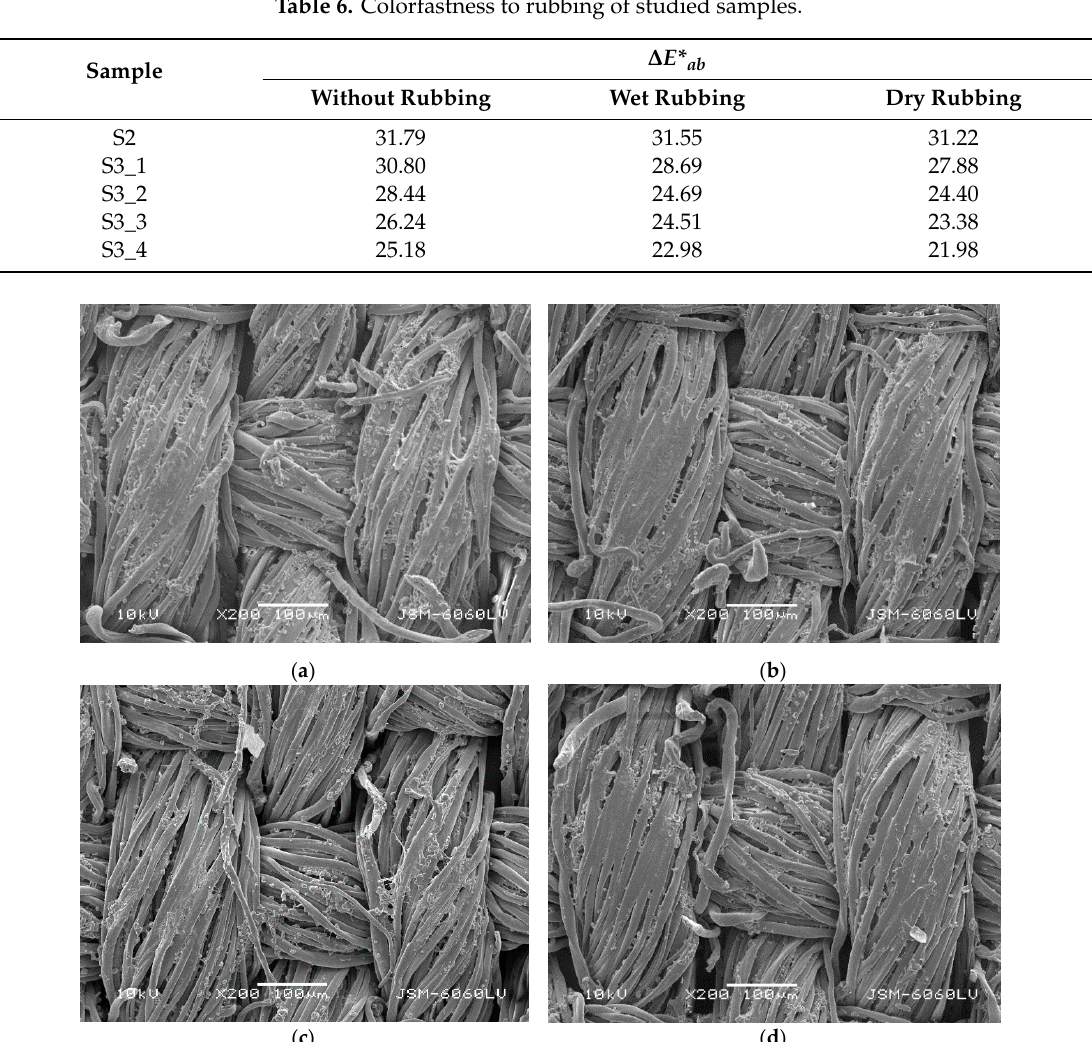
Figure 3. Sample S2 after wet ( a ) and dry ( b ) rubbing and sample S3_4 after wet ( c ) and dry ( d ) rubbing at 200× magnification.